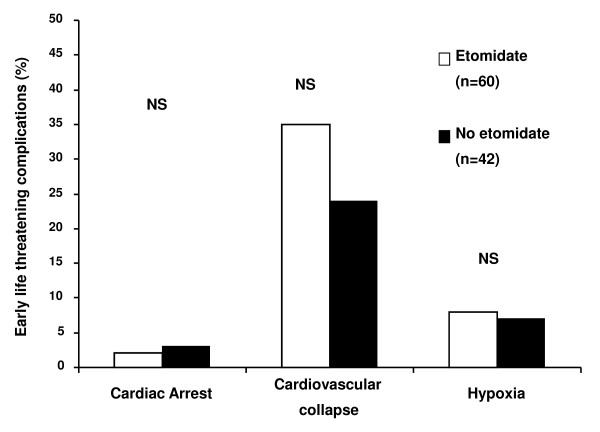
Incidence of life-threatening complications according to the hypnotic used to facilitate intubation. No difference in life threatening complications rates was found between the hypnotic used. NS, not significant.